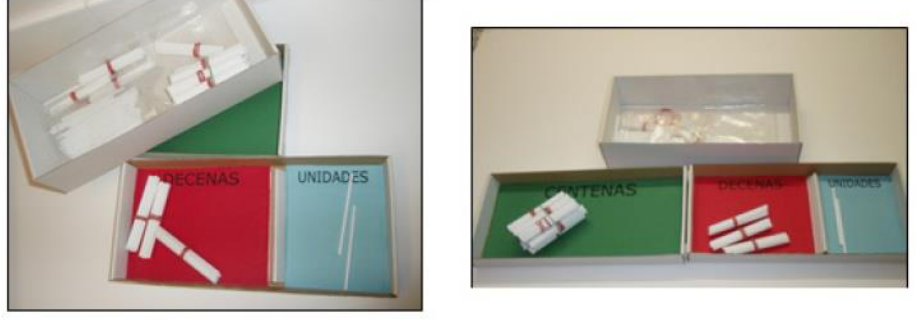
Figure 4. Numbering box.